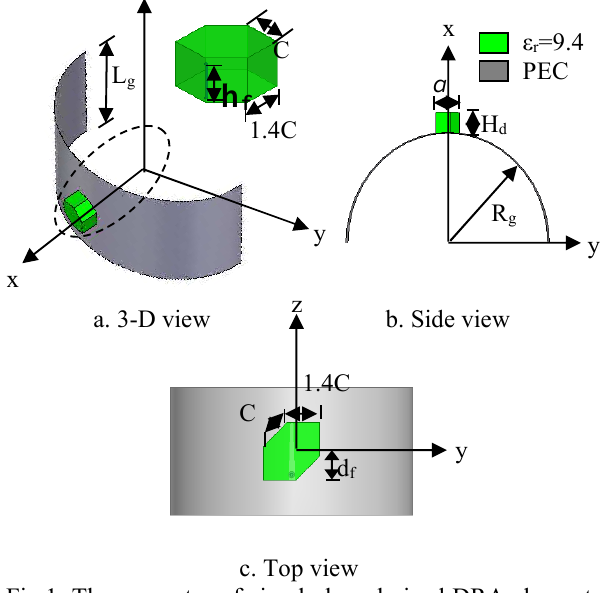
Fig.1. The geometry of circularly polarized DRA element mounted on a cylindrical ground plane. L g =110 mm, R g =27.5 mm, H d = 11.9mm and C= 5.312mm.